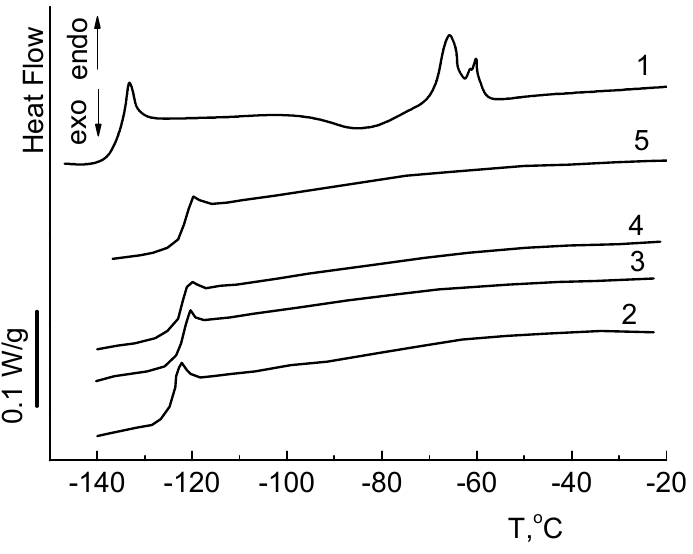
Figure 4. DSC curves for PDMS-15 (1) and Me 4 -15 (2), Tol 4 -15 (3), Ph 4 -15 (4), Ph r 4 -15 (5) star-shaped polymers at 10 ◦ C/min heating rate.